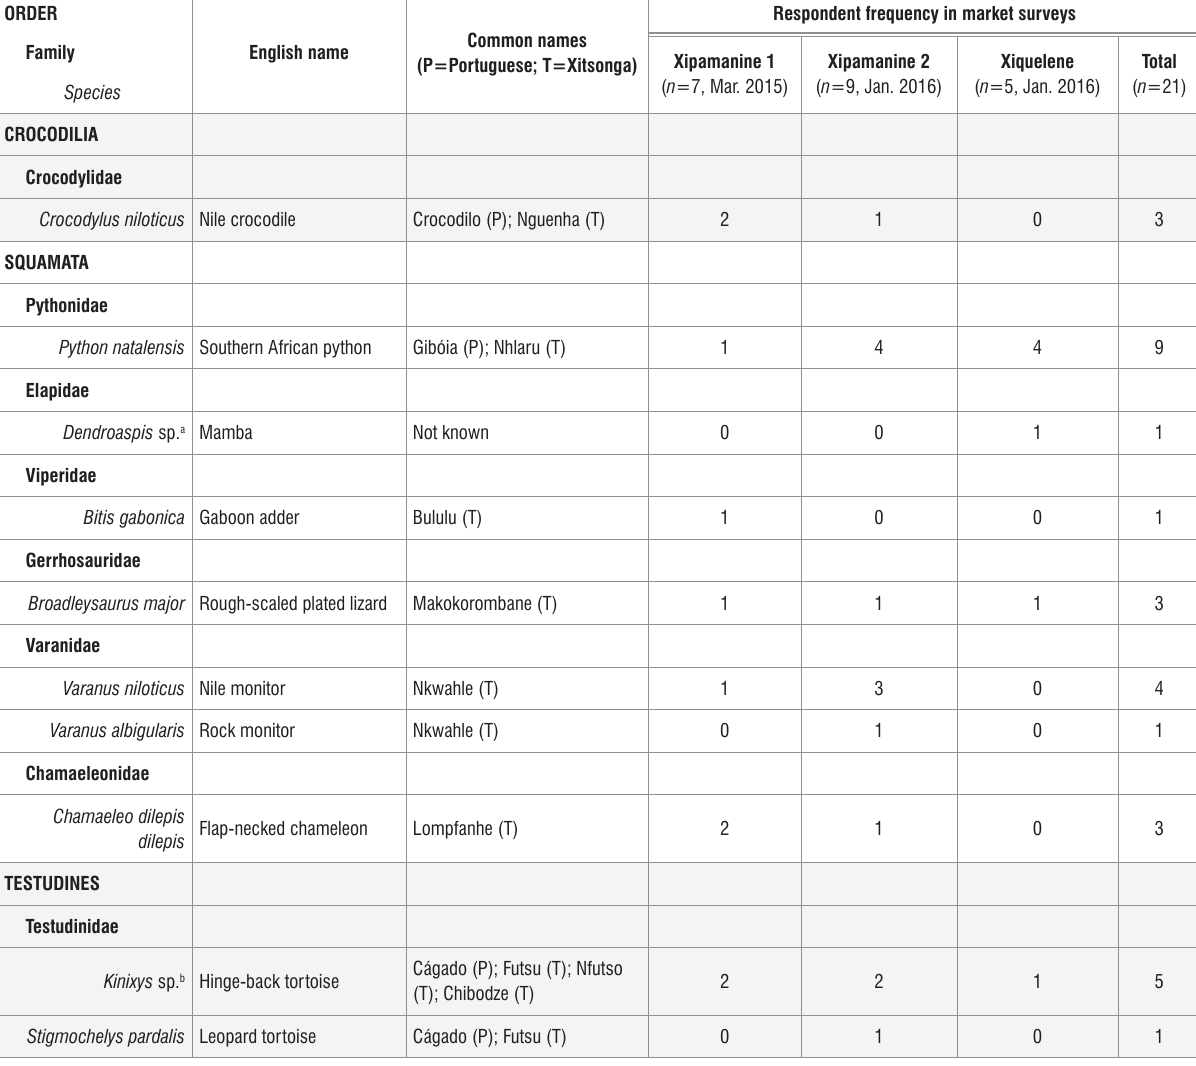
Reptile taxa, common names and observed frequencies in two surveys conducted in two markets